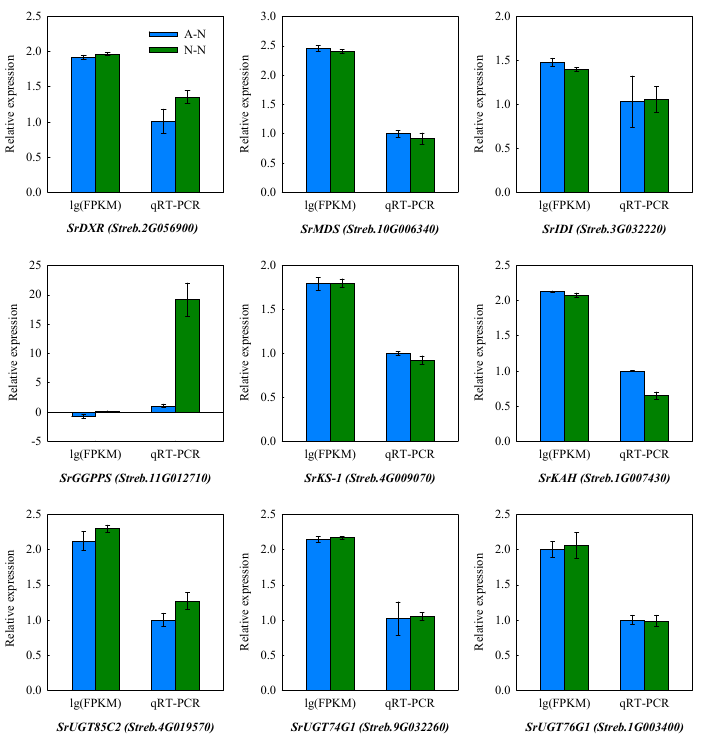
Figure 7. Quantitative real-time PCR (qRT-PCR) assessments of 9 genes encoding the key enzymes involving in steviol glycosides synthesis. Stevia plants were fed with either the ammonium form of nitrogen (A-N) or the nitrate form of nitrogen (N-N). Values represent the mean ± SD of three biological replicates.